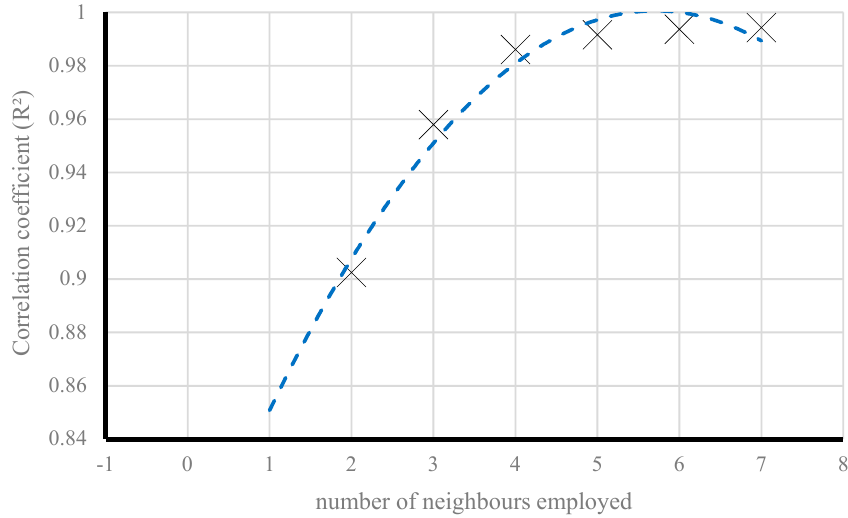
Figure 7. Variation of the correlation coefficient (R²) versus number of used KNN neighbors in lazy locally weighted learning (LLWL) technique.